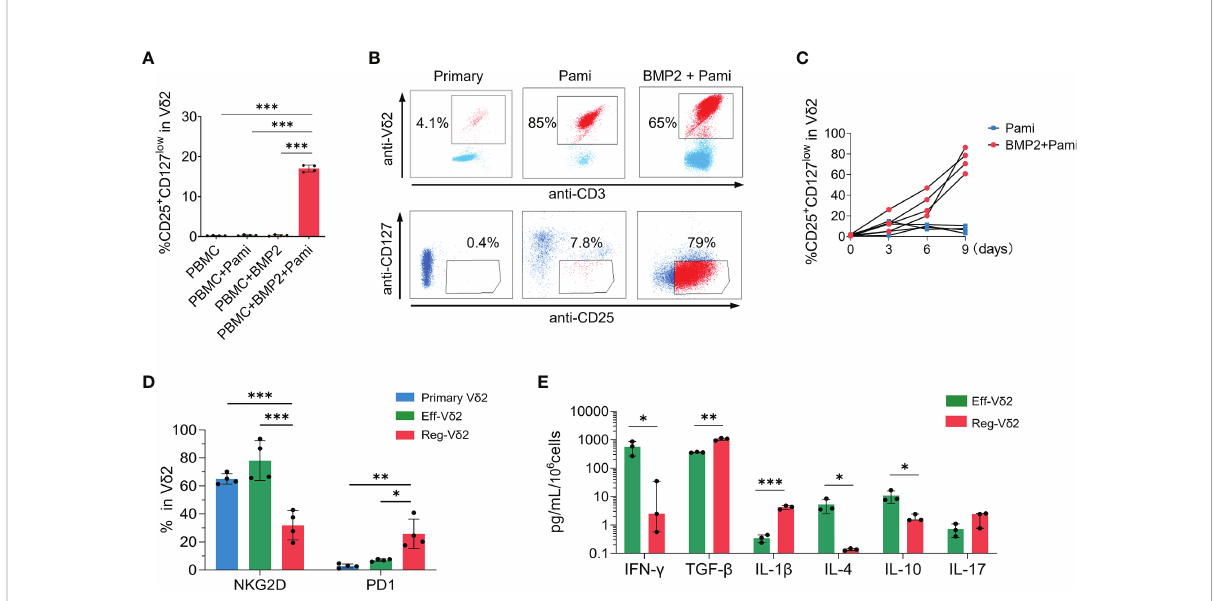
FIGURE 3 Immunophenotypes of CD25 + CD127 low V d 2 + T cells. (A) The proportions of CD25 + CD127 low V d 2 + T cells in V d 2 T cells were detected in PBMCs isolated from healthy donors after short-time stimulation with pamidronate with or without BMP2. (B) PBMCs isolated from healthy donors were used to expand Reg-V d 2 under conditions as described in Methods. Flow cytometry analyses showing the representative dot-plot images and proportions of V d 2 in CD3 + T cells and CD25 + CD127 low fraction in V d 2 cells at primary state and after stimulation of pamidronate with or without BMP2. (C) The statistical analyses of percentage of CD25 + CD127 low V d 2 + T cells (Reg-V d 2) in pamidronate and BMP2 plus pamidronate groups. (D) Expressions of NKG2D and PD1 in primary, Eff-V d 2 (Eff-V d 2 cells were expanded as described in Methods), and Reg-V d 2 cells were detected by fl ow cytometry. n = 4, * P < 0.05, *** P < 0.001. (E) Secretions of IFN- g , TGF- b , IL-1 b , IL-4, IL-10, and IL-17 from Eff-V d 2 and Reg- V d 2 cells were detected by ELISA assays. n = 3, * P < 0.05, ** P < 0.01, *** P <